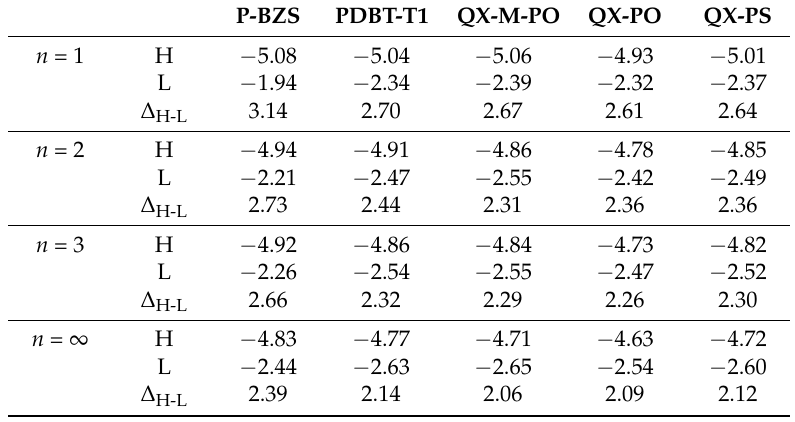
Table 1. Energy levels of the highest occupied molecular orbital (HOMO (H)), the lowest unoccupied molecular orbital (LUMO (L)) (eV) and the energy gap ∆ H-L (eV) for all oligomers.